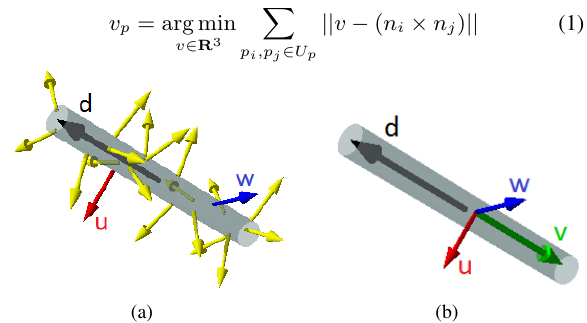
Figure 3: (a) Cylinder with direction d and surface normals. (b) The cross product v of normals u, w is collinear with d